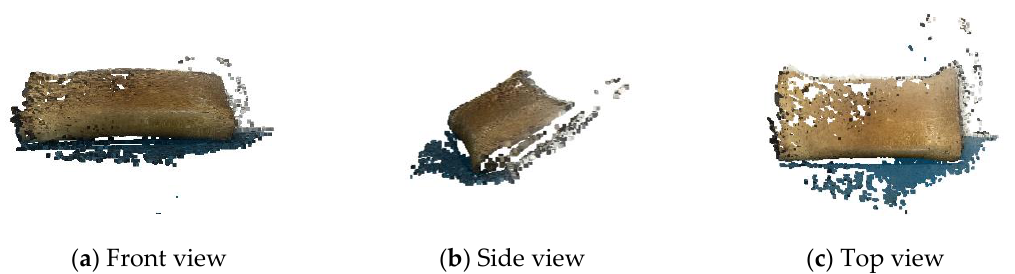
Figure 14. ( a – c ) are the dense point-cloud models observed in front view, side view and top view, respectively.